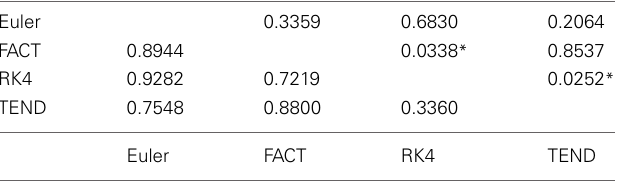
Table 3 | Functional data analysis is used along with permutation testing to look for differences in rich club coefficients generated from different fiber tracking